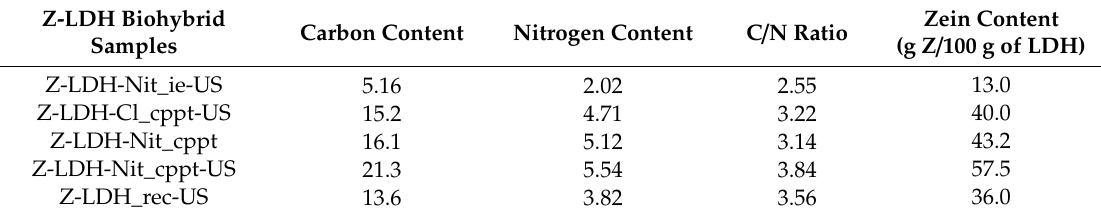
Table 1. Zein content in Z-LDH biohybrids prepared by di ff erent methods. The amount of zein was calculated from the content of carbon in the